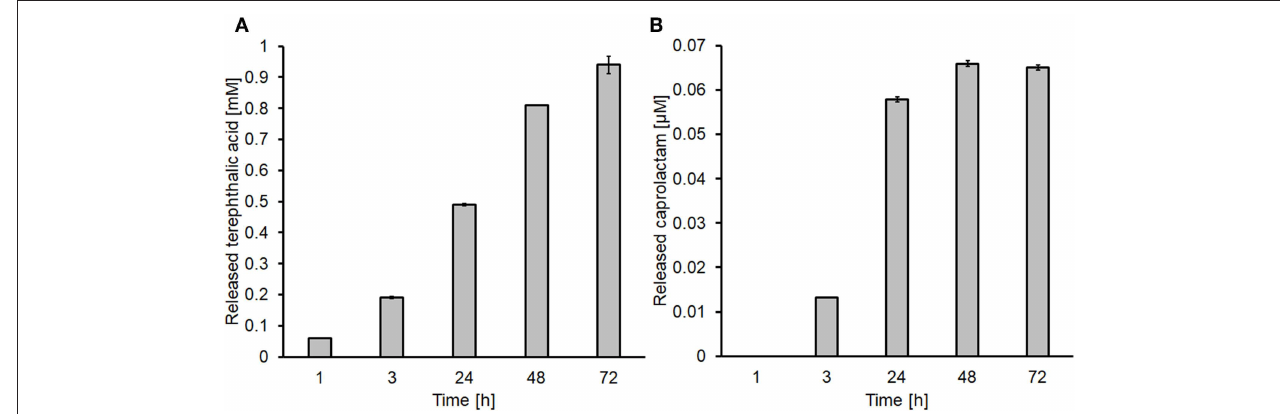
TABLE 1 | Color changes of PET and nylon surface before and after enzymatic treatment.